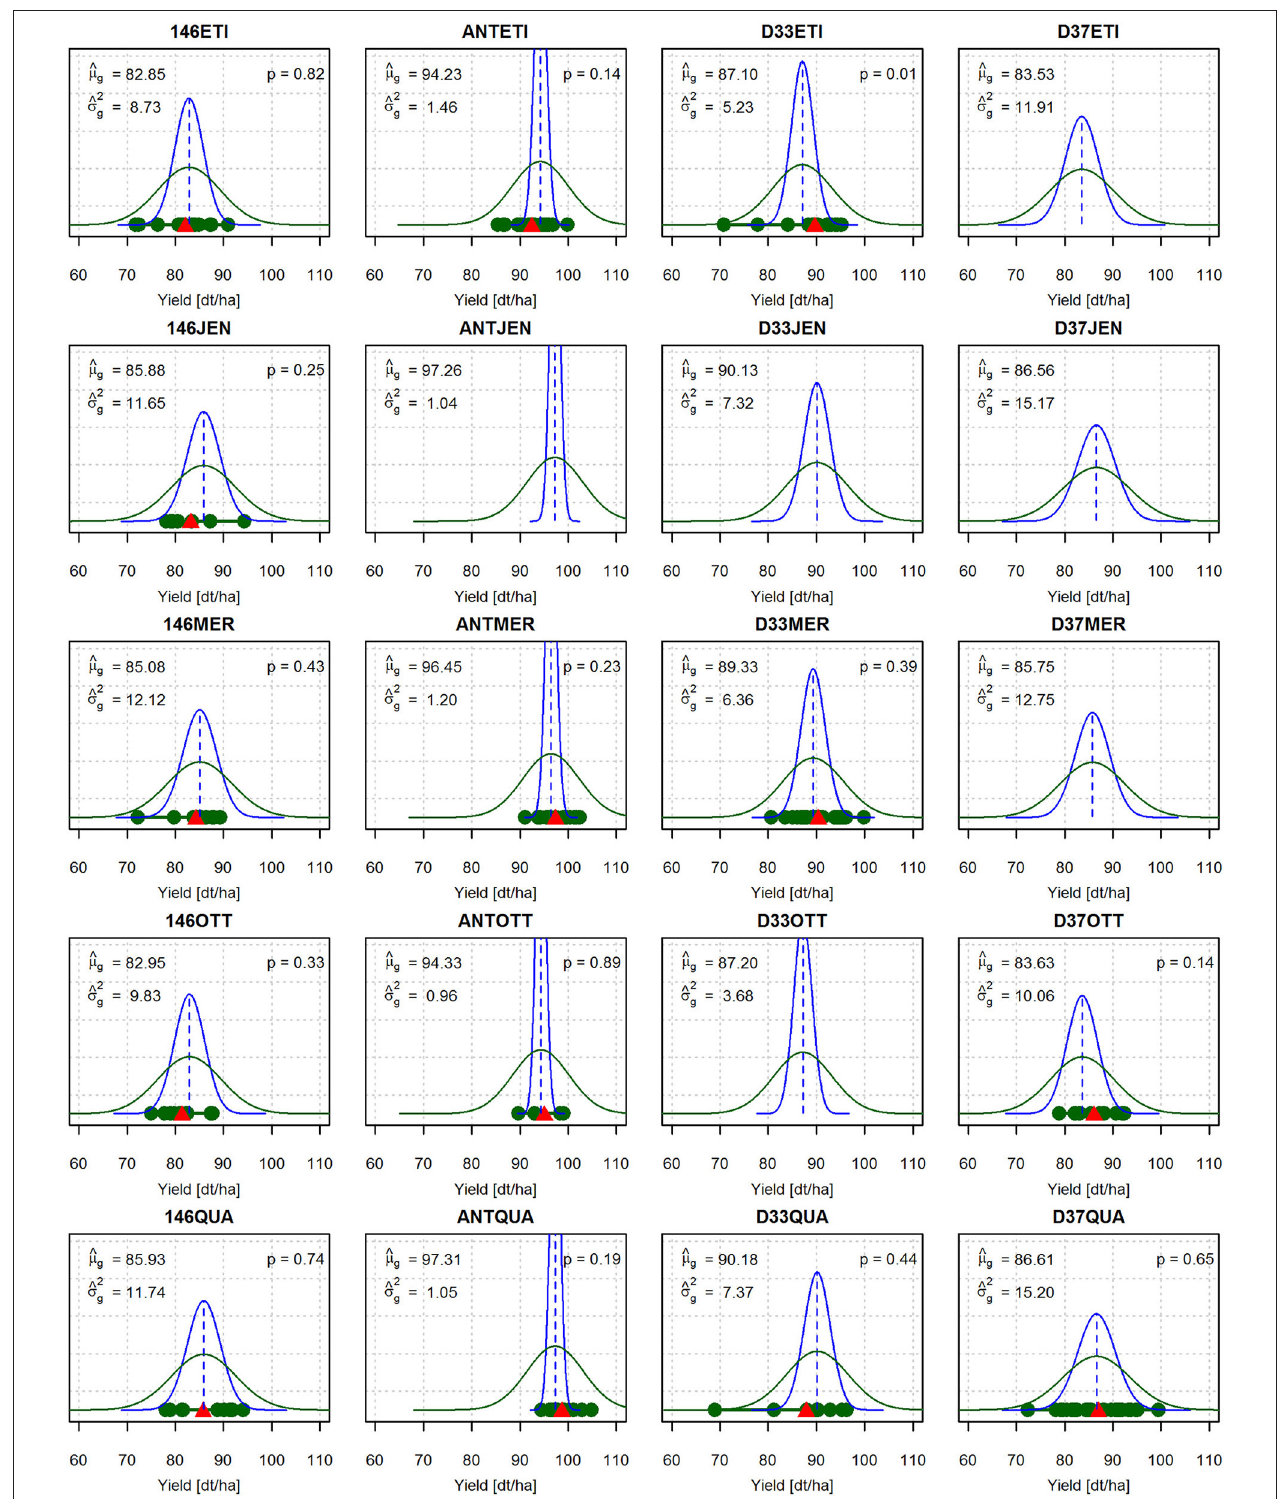
FIGURE 2 | Marker-based predictions of the genetic means ˆ µ g and variances ˆ σ 2 g of the DH lines derived from all crosses of the complete factorial. The density of a normal distribution with the predicted genetic parameters N (cid:16) ˆ µ g , ˆ σ 2 g (cid:17) is depicted in blue. The density of a normal distribution with the predicted